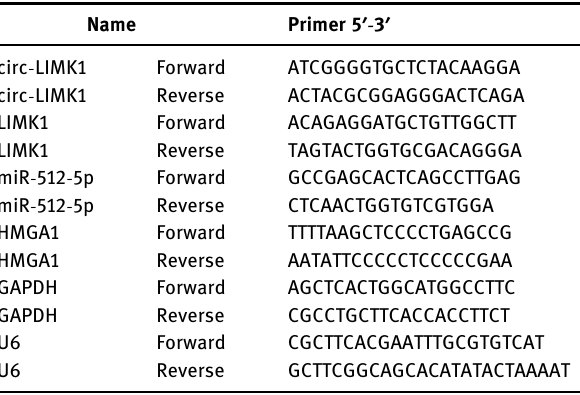
Table 2: The primer sequences for RT -